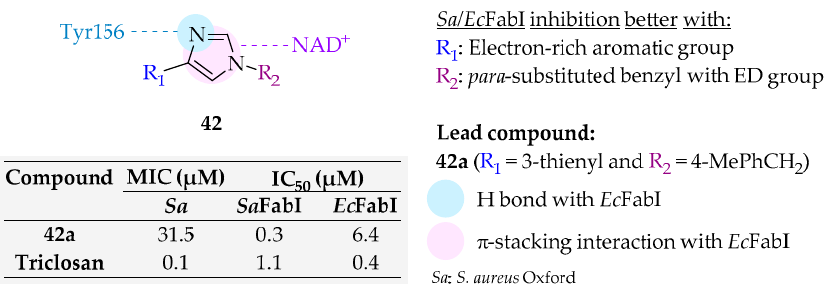
Figure 35. Structure, SAR and representation of main interactions with Ec FabI of imidazoles 42 and in vitro activities of lead compound